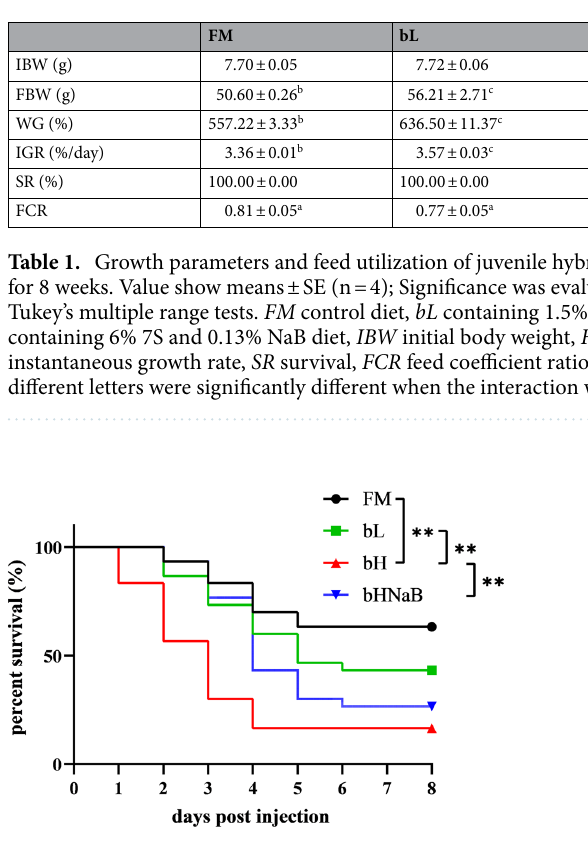
Figure 1. Cumulative survival against Vibrio parahaemolyticus of juvenile hybrid grouper after feeding with the four experimental diets for 8 weeks. Mortality was measured in each treatment groups (n = 40) and was recorded every 12 h post-injection (*indicates P < 0.05 and **indicates P < 0.01). Median survival was undefined in the FM (black), 5 days in the bL (green), 3 days in the bH (red) and 4 days in the bHNaB (blue). The Chi square values of each comparison objects are 2.216 for FM vs bL, 18.89 for FM vs bH, 10.17 for bL vs bH and 7.303 for bH vs